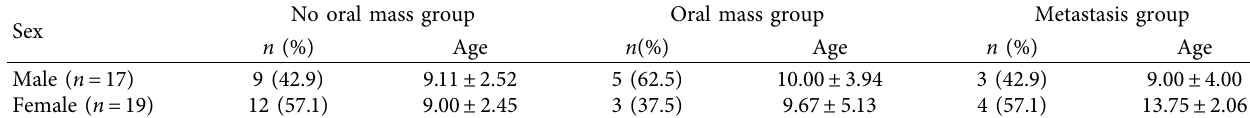
Table 1: Te sex and age (mean ± standard deviation, SD) of dogs in this study.